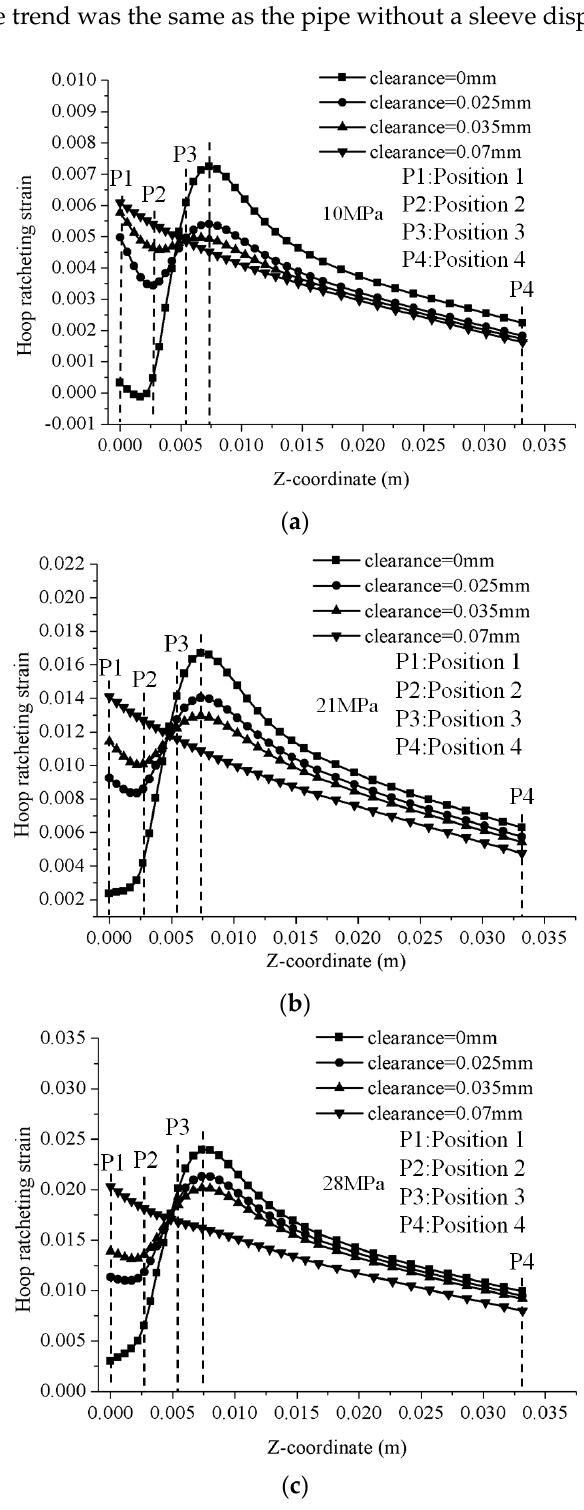
Figure 11. The ratcheting strain distribution of the pipe with a sleeve between Position 1 and Position 4 considering different clearances under different internal pressures after 45 cycles: ( a ) 10 MPa, ( b ) 21 MPa, and ( c ) 28 MPa.